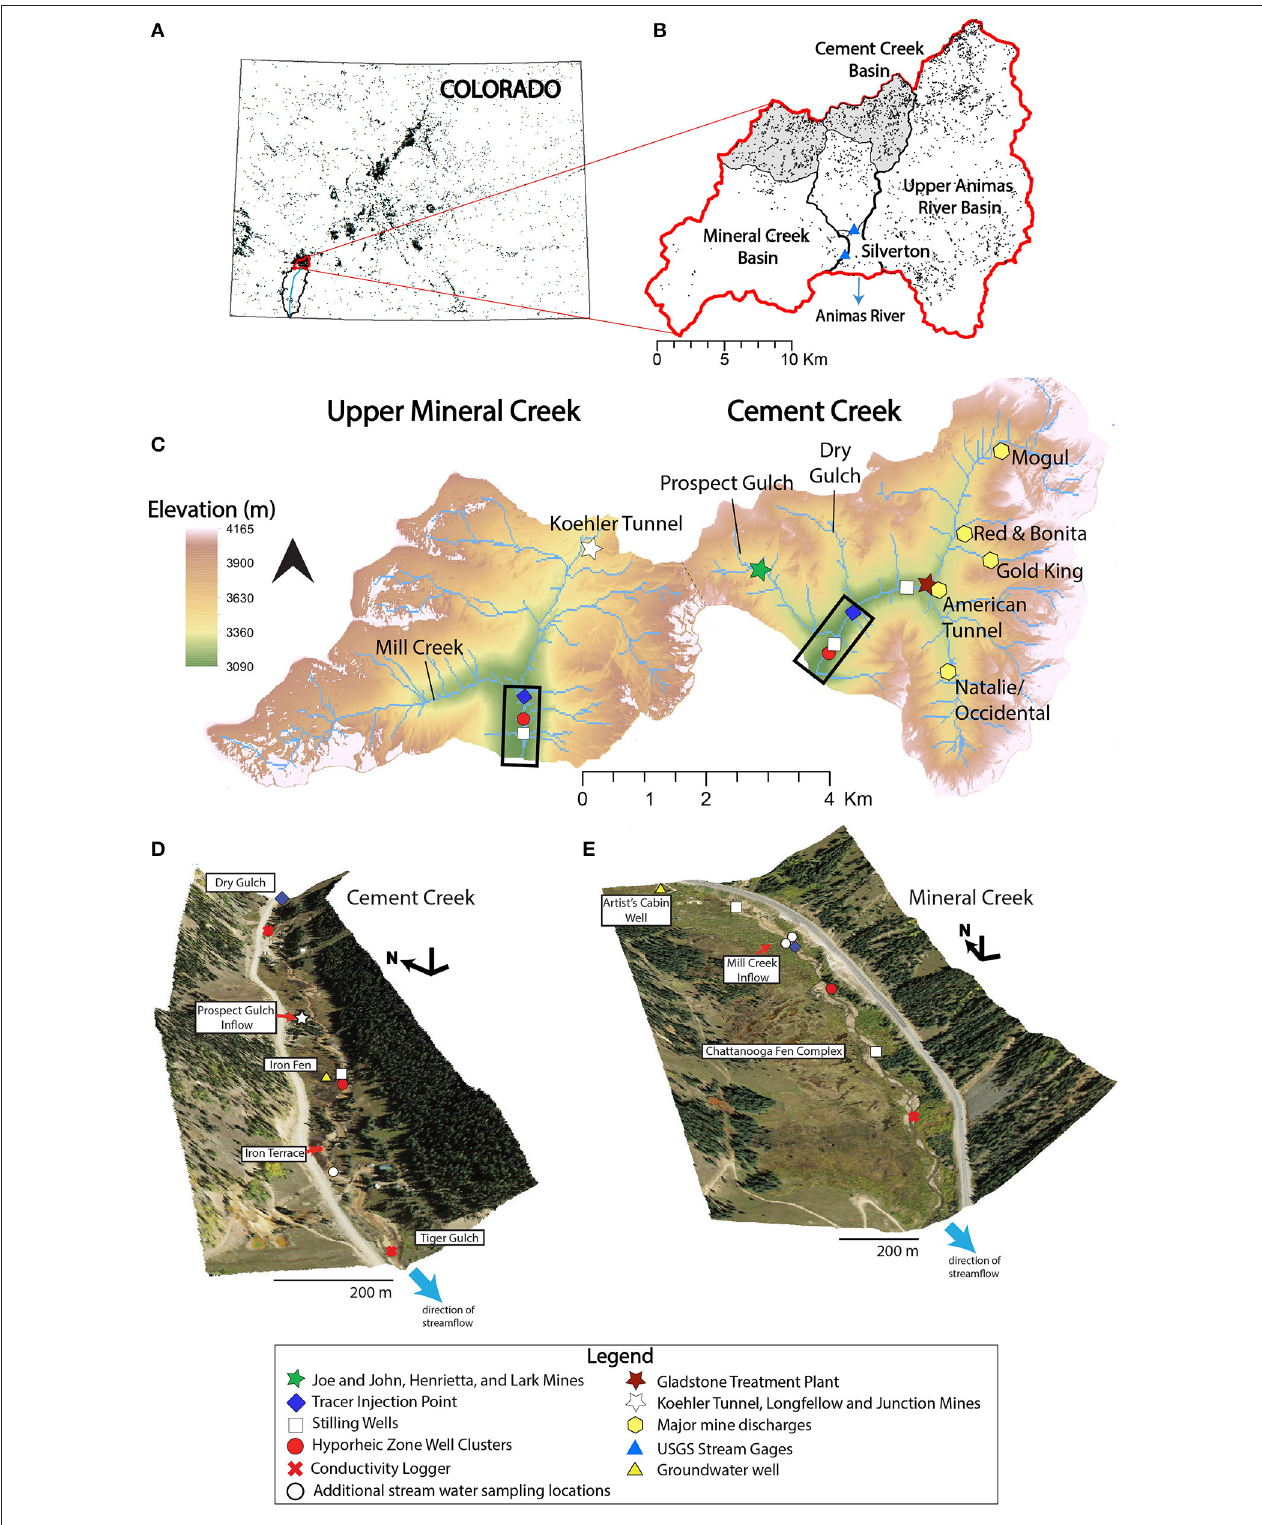
FIGURE 1 | The upper Mineral Creek and Cement Creek study areas are located at (A) the headwaters of the Animas River watershed in (B) the Bonita Peak Mining District north of Silverton, in the San Juan Mountains of southwestern Colorado. The study areas and the locations of the redox-sensitive metal sources